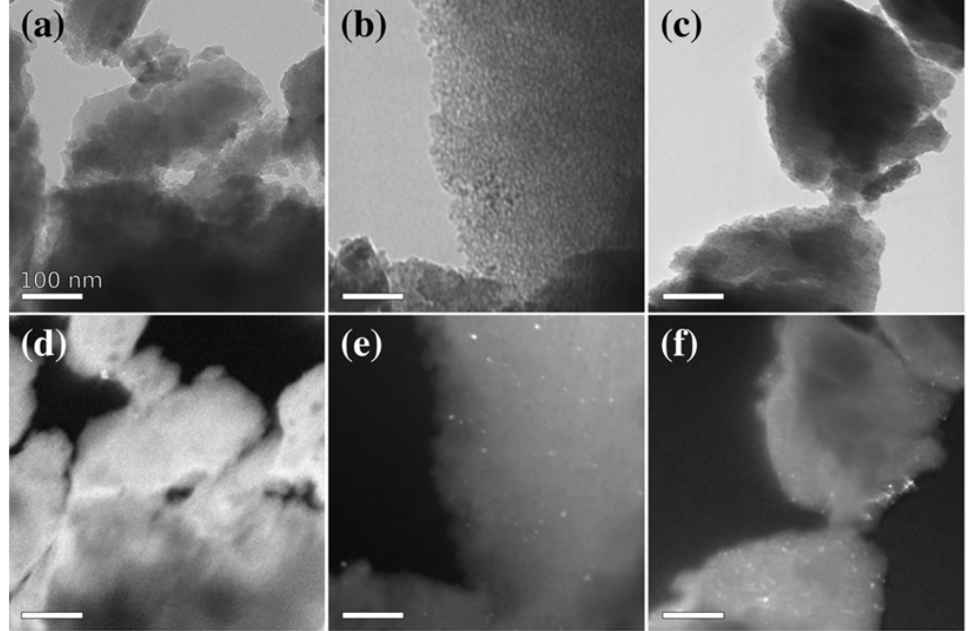
Figure 4. Representative bright field (BF) ( a – c ) and dark field (DF) ( d – f ) TEM images of xerogel samples treated at 900 °C with increasing loading of 5 wt% ( a , d ), 10 wt% ( b , e ) and 15 wt% ( c , f ). All scalebars correspond to 100 nm.